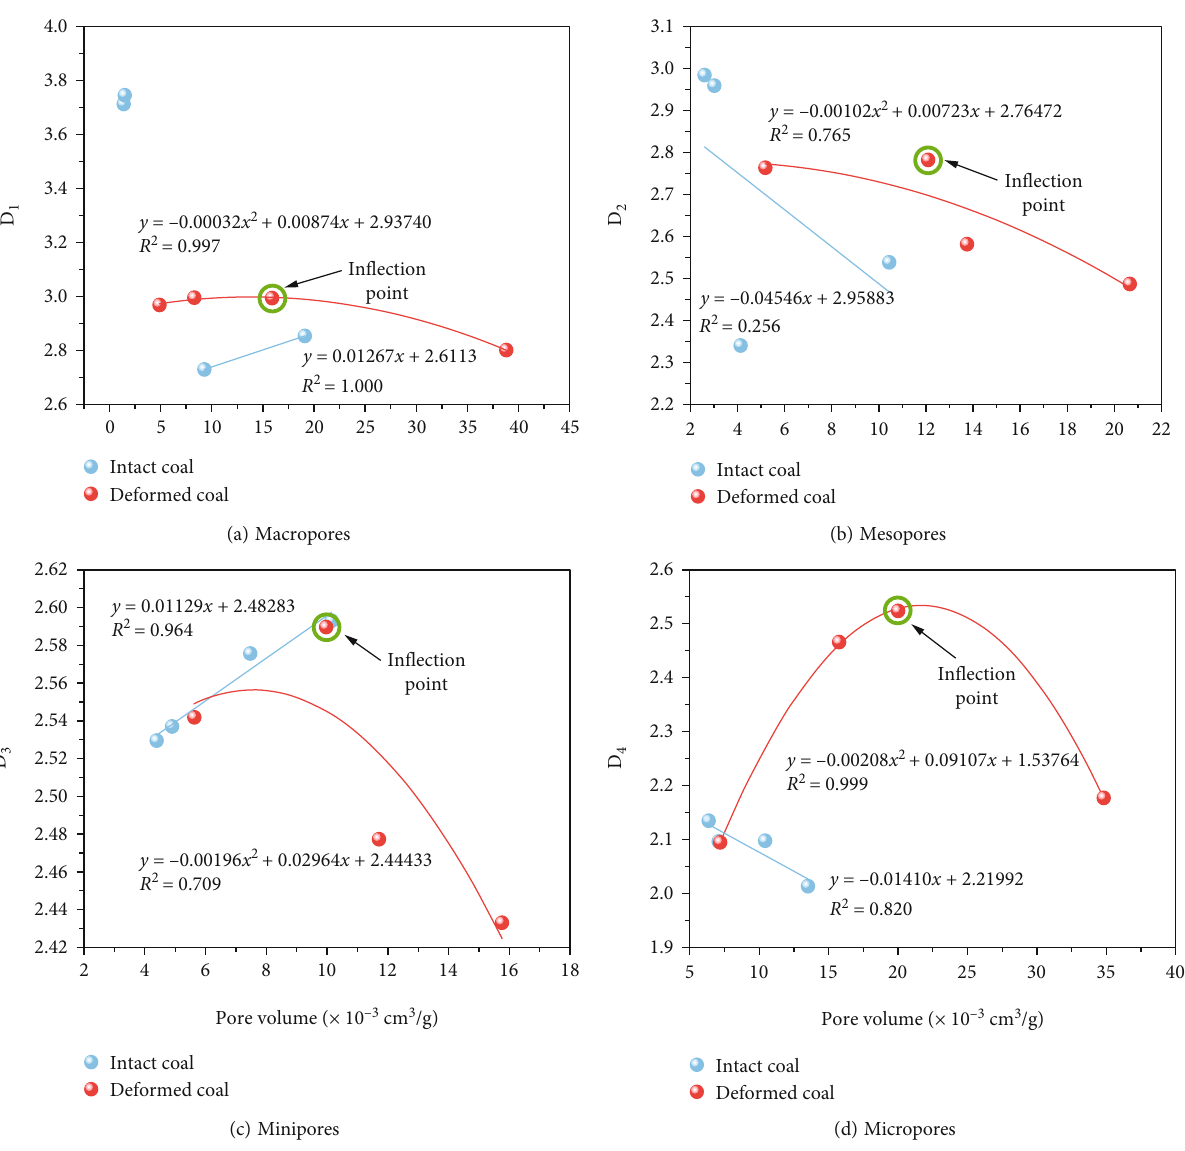
Figure 10: Relationship between pore volumes and fractal